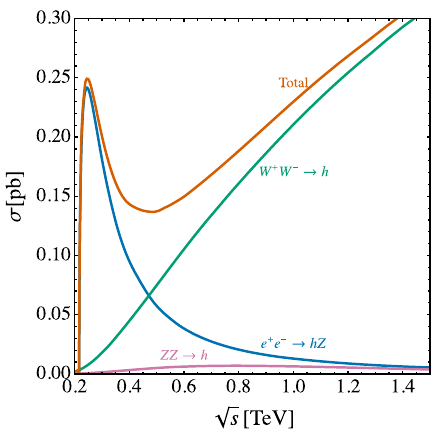
Fig. 3 LeadingorderHiggsproductioncrosssectionsat e + e − colliders as a function of the center-of-mass energy, produced with MadGraph5